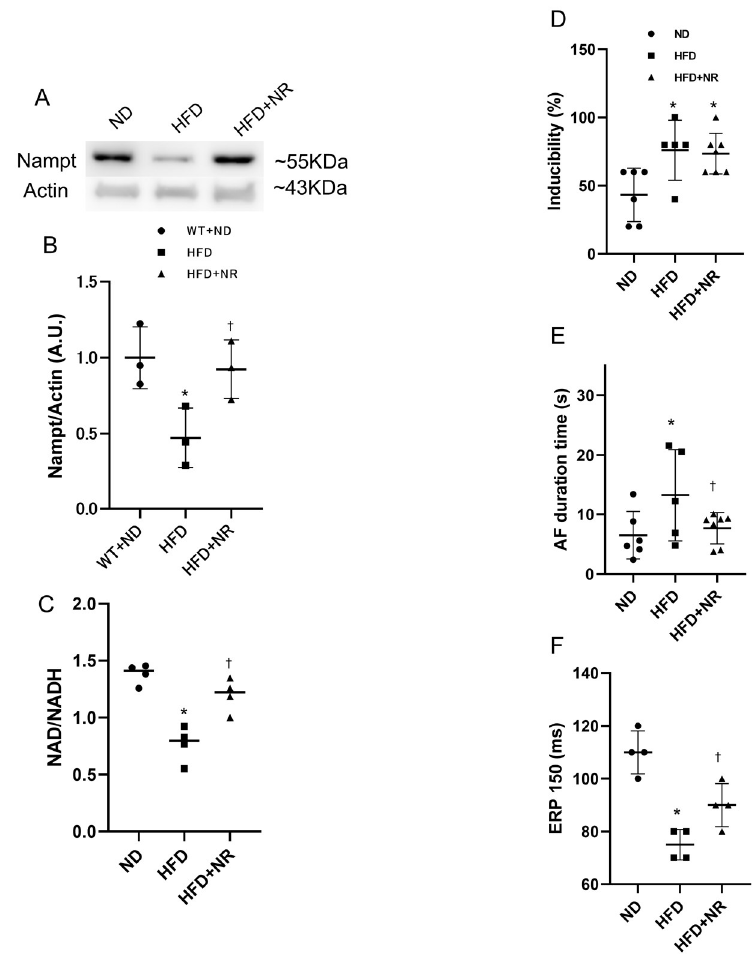
Figure 6. Effect of NR on HFD-induced AF. ( A ) Representative images of western blots for Nampt. ( B ) Nampt protein expression levels in the atrial tissues ( n = 3 mice per each group). ( C ) Scatter chart of NAD/NADH ratio ( n = 4 mice per each group). ( D ) Scatter chart of AF inducibility. ( E ) Scatter chart of AF duration. ( F ) Scatter chart of AERP. * p < 0.05 vs. ND mice; † p < 0.05 vs. HFD mice ( n = 6 in ND group, n = 5 in HFD group, n = 7 in HFD+NR group). Statistical comparisons between multiple groups: one-way ANOVA followed by a post-hoc Bonferroni